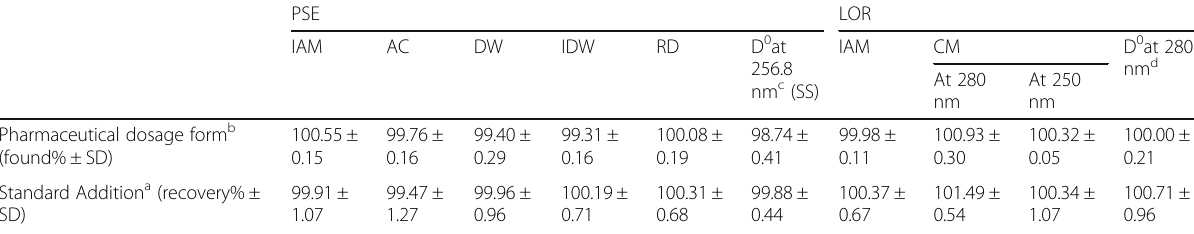
IAM CM 256.8 At 280 At 250 nm c (SS) nm nm